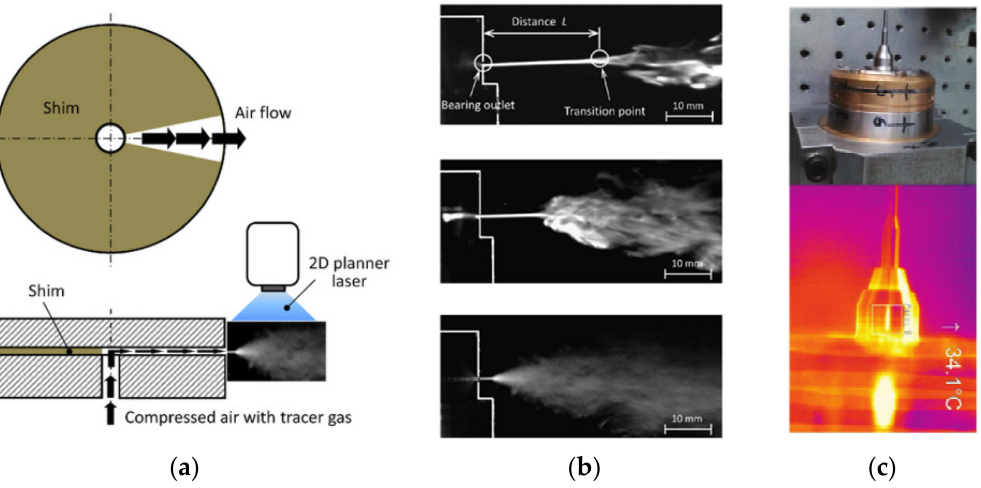
Figure 7. Visualization technology applied in the experiment of ATBs. ( a ) the test bench [42]. ( b ) visual flow with a 2D planar YAG laser and high ‐ speed digital CCD camera [42]. ( c ) temperature of shaft nose using a thermal imager [2].